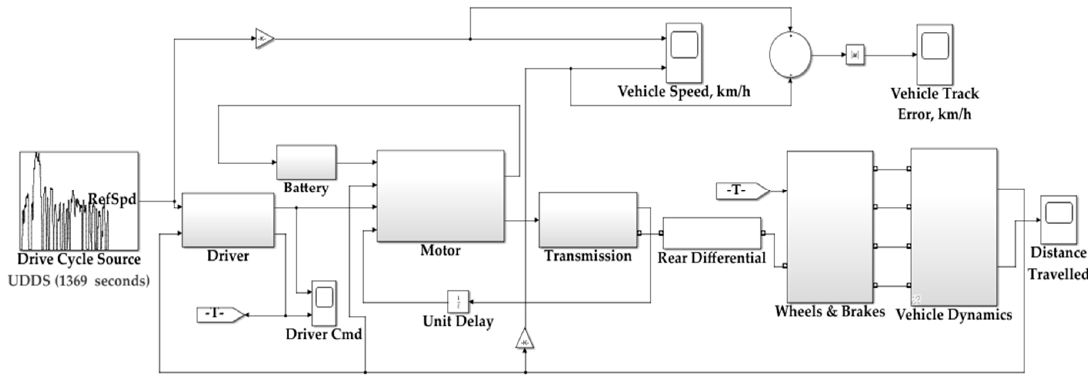
Figure 8. EV model layout within the MATLAB/Simulink platform.